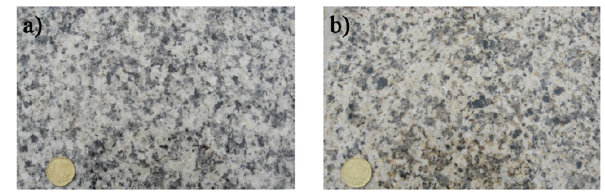
Fig. 6. Polished sections of (a) Azul Platino and (b) Amarillo Platino